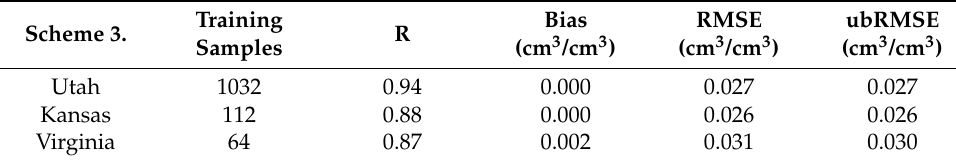
Figure 18. The distribution and land cover of U.S. states, where Utah, Kansas, and Virginia are highlighted. The source of land cover is GlobeLand30. Table 7. Evaluation of different U.S.